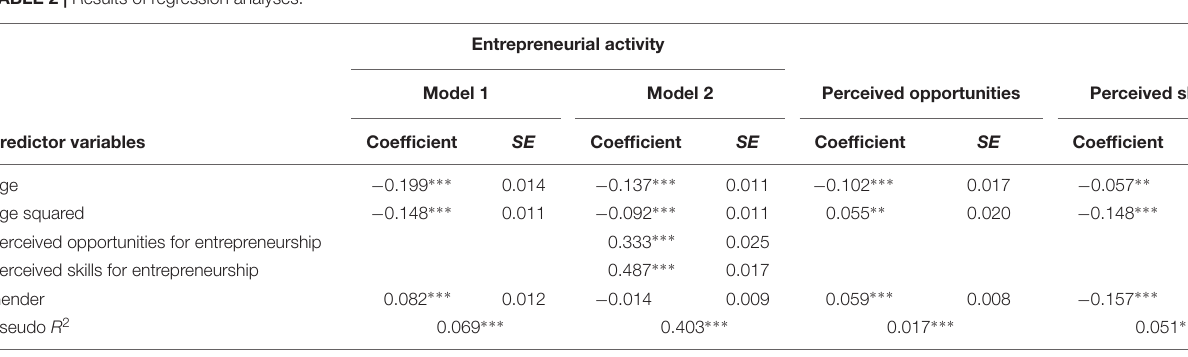
TABLE 2 | Results of regression analyses.